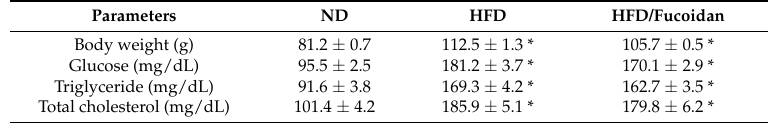
Table 1. Changes in body weight, blood glucose levels, and serum lipid concentrations in the ND-fed group, HFD-fed group and HFD/Fucoidan-fed group.